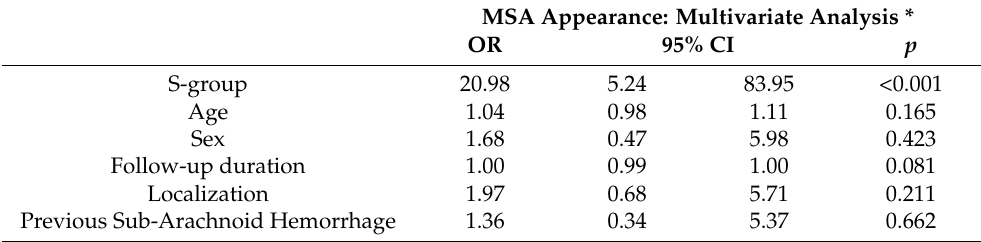
Table 3. Link of magnetic susceptibility artifacts (MSA) appearance with belonging in the S-group through the results of multivariate logistic regression. * Multivariate logistic regression, Bootstrap replication: 50, Pseudo-R2: 23.26%; p =